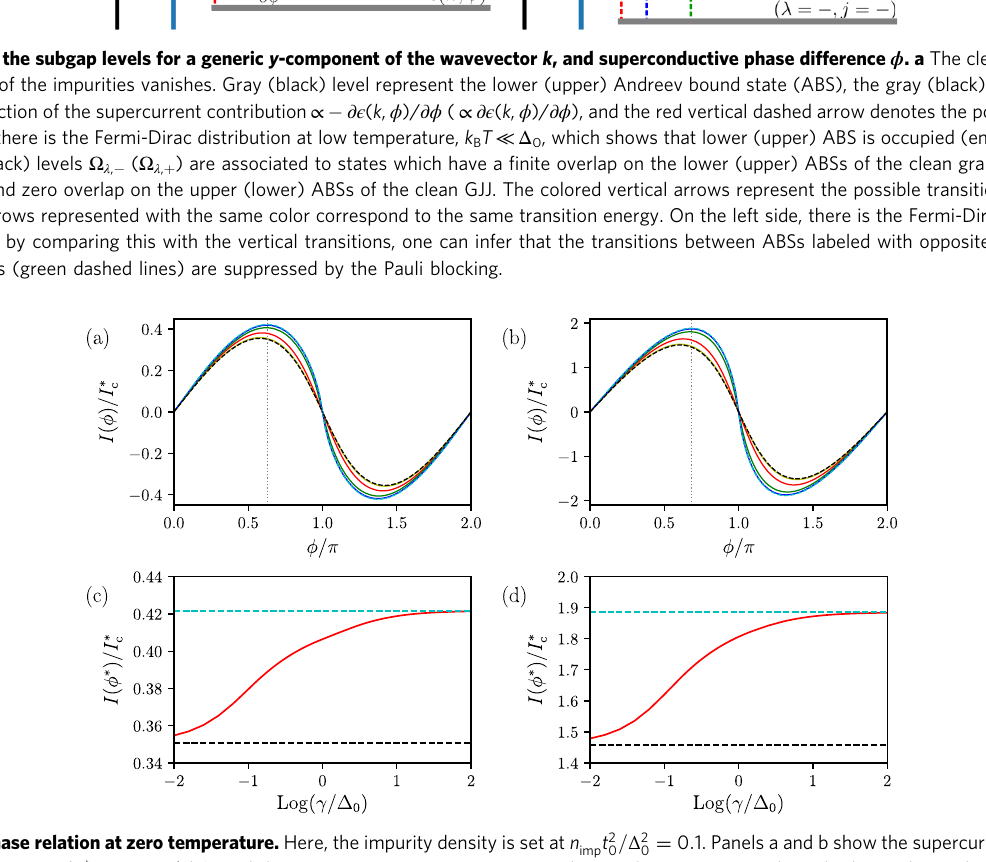
hybridization is maximal, namely for k such that τ ( k ) ~ 1. Figure 3a, b show the CPR at zero temperature, obtained by using Eq. (24), with = Δ = 0 ¼ 0 : 1, for different values of γ , at zero doping, μ t 2 n 0 imp 0 0 (Fig. 3a) and at the fi nite doping level μ 0 = 5 ℏ v D / L (Fig. 3b). In both cases we observe that in the clean limit ( γ → ∞ ) the CPR shows the largest skewness and critical current. For fi nite values of γ , the hybridization between the ABSs and the impurities sets in. As a consequence, both skewness and critical current reduce. This effect can explained by observing that the modes mainly affected by the presence of disorder are the high transparent ones, τ ( k ) ~ 1. These modes are also the ones largely responsible for skewness of the clean GJJ giving a supercurrent contribution / ∂ ϵ ð k ; ϕ Þ = ∂ ϕ (cid:7) Δ sin ð ϕ = 2 Þ , 0 whereas modes with low transparency imply the standard sinusoidal dependence / sin ð ϕ Þ . The phase difference where the supercurrent is